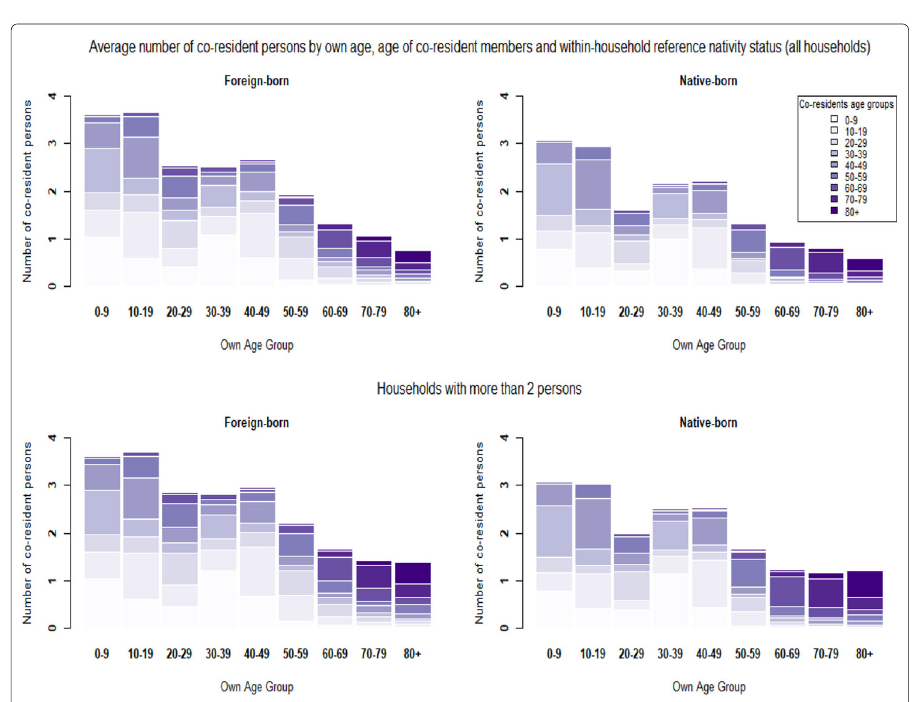
Fig. 6 Household structures by head-of-household nativity status